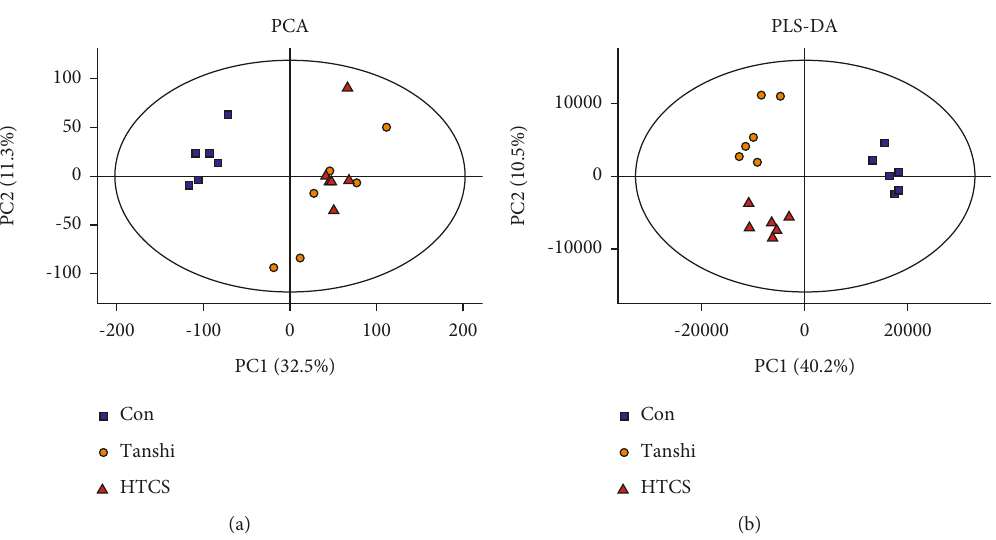
Figure 3: Score plots of PCA and PLS-DA. (a) Score plot of principle component analysis (PCA). (b) Score plot of partial least squares- discriminant analysis (PLS-DA). Abbreviations: HTCSD: Huo-Tan-Chu-Shi decoction.